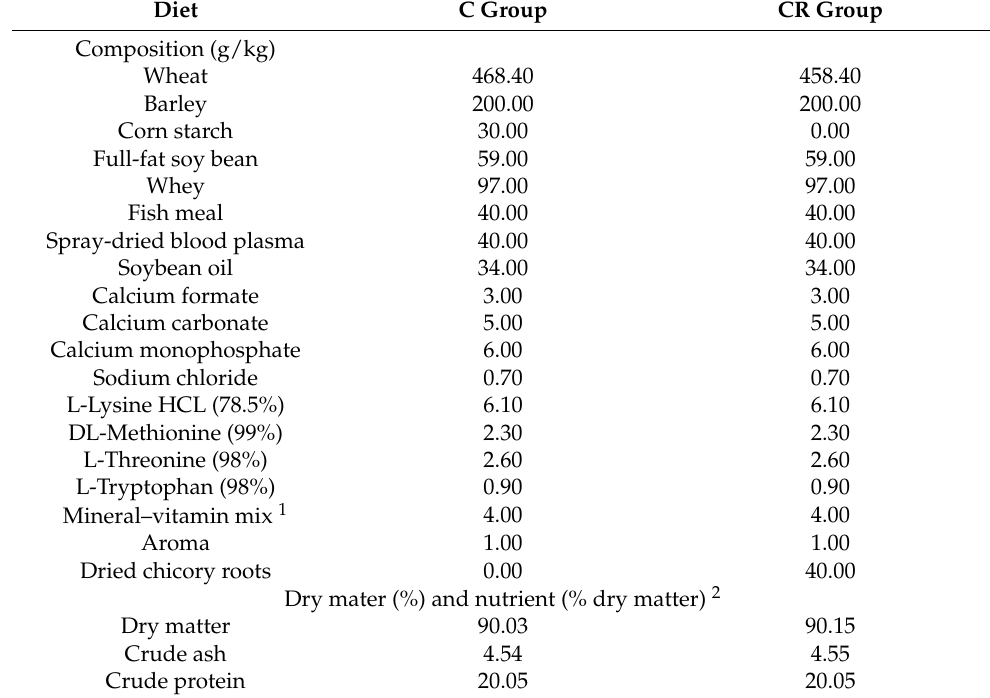
Table 1. Composition of the control diet (C) and the diet supplemented with 4% dried chicory root